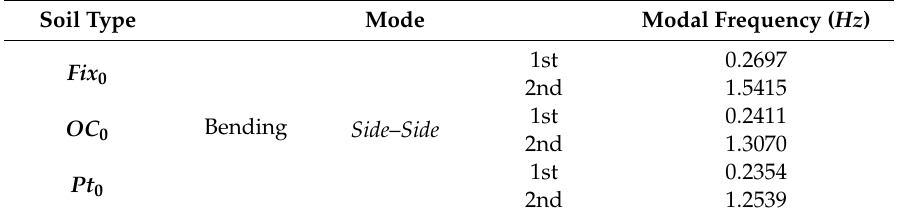
Table 3. First and second natural bending frequencies for the three developed models.